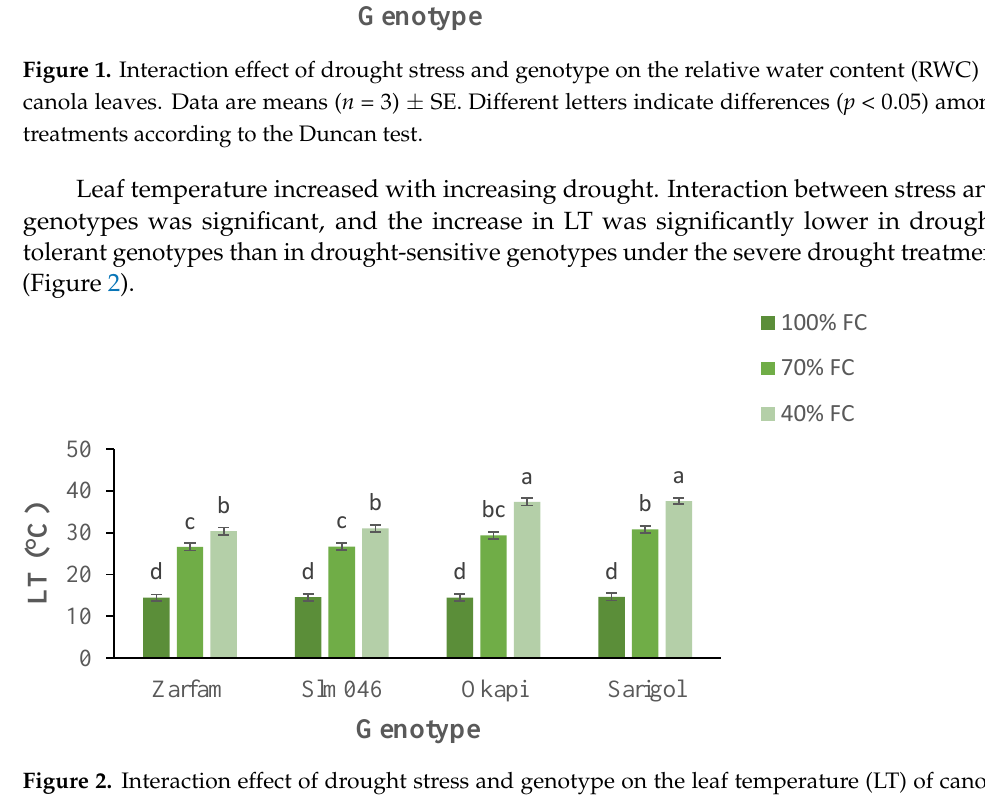
Figure 2. Interaction effect of drought stress and genotype on the leaf temperature (LT) of canola plants. Data are means ( n = 3) ± SE. Different letters indicate differences ( p < 0.05) among treatments according to the Duncan test.